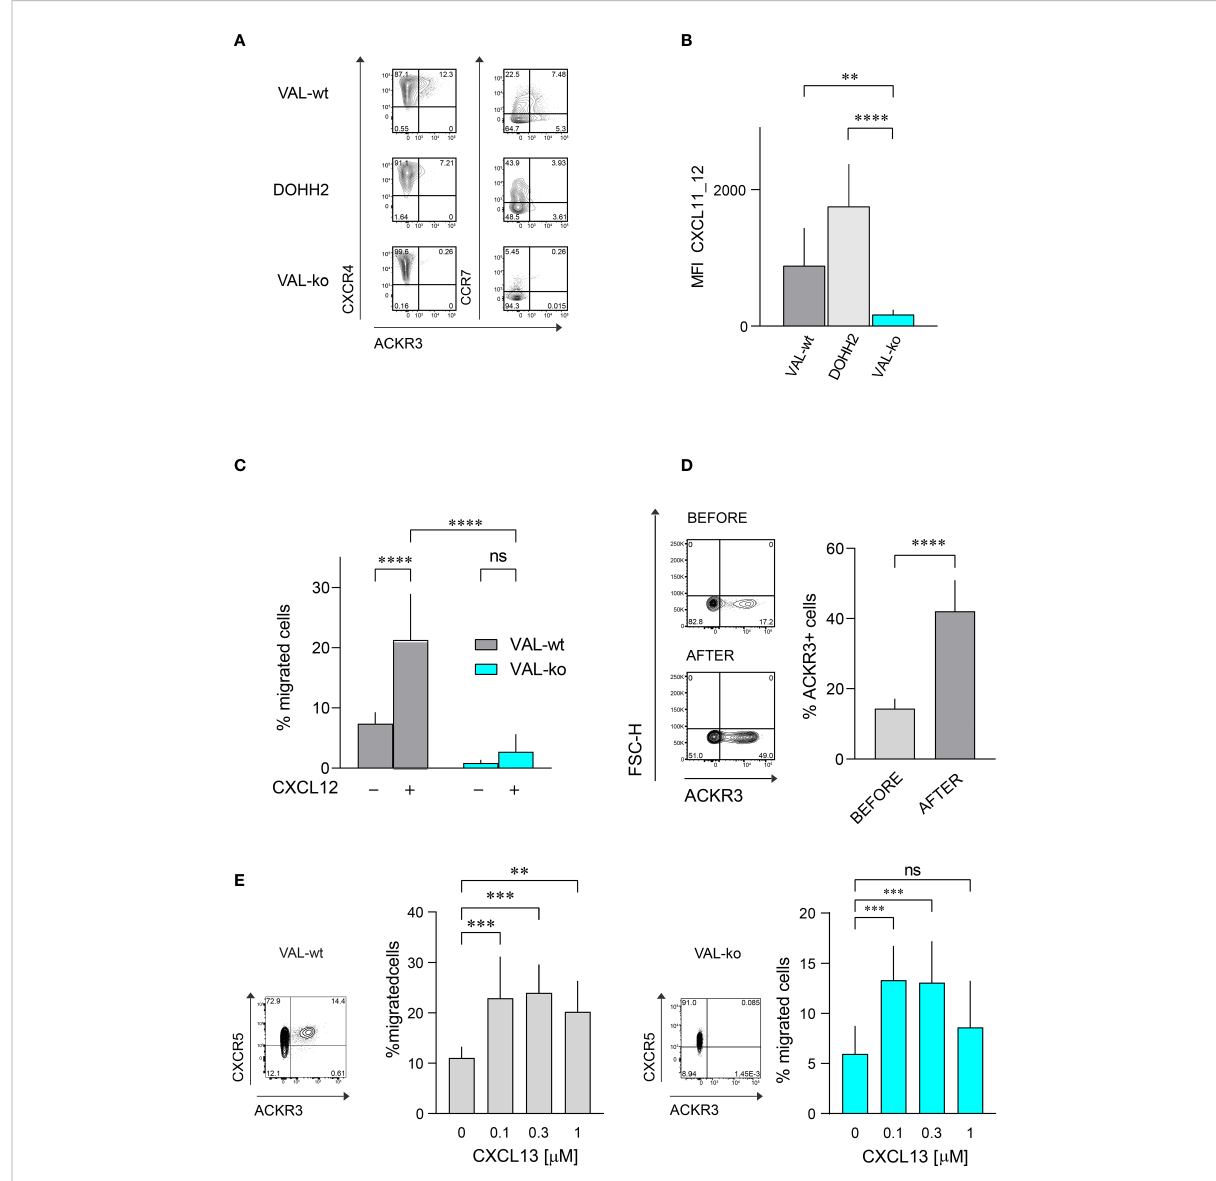
FIGURE 1 Chemokine receptor expression and function on DLBCL cells. (A) ACKR3 (mAb 11G8), CXCR4 (mAb 12G5) and CCR7 (mAb G043H7) surface expression on VAL-wt, DOHH2, and VAL-ko was measured by fl ow cytometry. Representative plots of three independent experiments. (B) Uptake of the chimeric chemokine CXCL11_12 AF647 by DLBCL. Mean fl uorescence intensity (MFI) of DLBCL incubated with 50 nM of CXCL11_12 for 45 min at 37°C. MFI (by fl ow cytometry) reports the mean ± SD (Dunnett ’ s multiple comparisons, ONE-WAY ANOVA **p ≤ 0.01, ****p ≤ 0.0001) offour independent experiments performed in triplicates. (C) Transendothelial migration of lymphoma cells. VAL cell migration through mLEC towards 10 nM CXCL12 was measured after 8h incubation. Cell migration was calculated as percentage of the input (% migrated cells). Cumulative data from three independent experiments measured in triplicates (means ± SD, Turkey ’ s multiple comparison ONE-WAY ANOVA ns (not signi fi cant), p ≥ 0.05, ****p ≤ 0.0001). (D) (Left) ACKR3 (mAb 11G8) surface expression on VAL-wt cells before (upper panel, before) and after transendothelial migration (lower panel, after) towards 10 nM CXCL12 as in (C) . Representative plots from ten independent experiments performed in duplicates. (Right) Percentage of cells expressing ACKR3 on the plasma membrane before and after migration. Cumulative data from fi ve different experiments measured in triplicates (means ± SD, unpaired t-test, ****p ≤ 0.0001). (E) Left side: fl ow cytometry plot showing ACKR3 (mAb 11G8) and CXCR5 (mAb J252D4) surface expression on VAL-wt (left panel). Transendothelial migration of VAL-wt towards increasing concentrations of CXCL13 (0.1, 0.3 and 1 µM) (bar chart). Right side: fl ow cytometry plot showing ACKR3 (mAb 11G8) and CXCR5 (mAb J252D4) surface expression on VAL-ko (left panel). Transendothelial migration of VAL-ko through mLEC towards increasing concentrations of CXCL13 (0.1, 0.3 and 1 µM) (bar chart). Cell migration was calculated as described above. Bar charts show cumulative data of three independent experiments performed in triplicates (means ± SD, Dunnett ’ s multiple comparisons, ONE WAY ANOVA, **p ≤ 0.01, ***p ≤